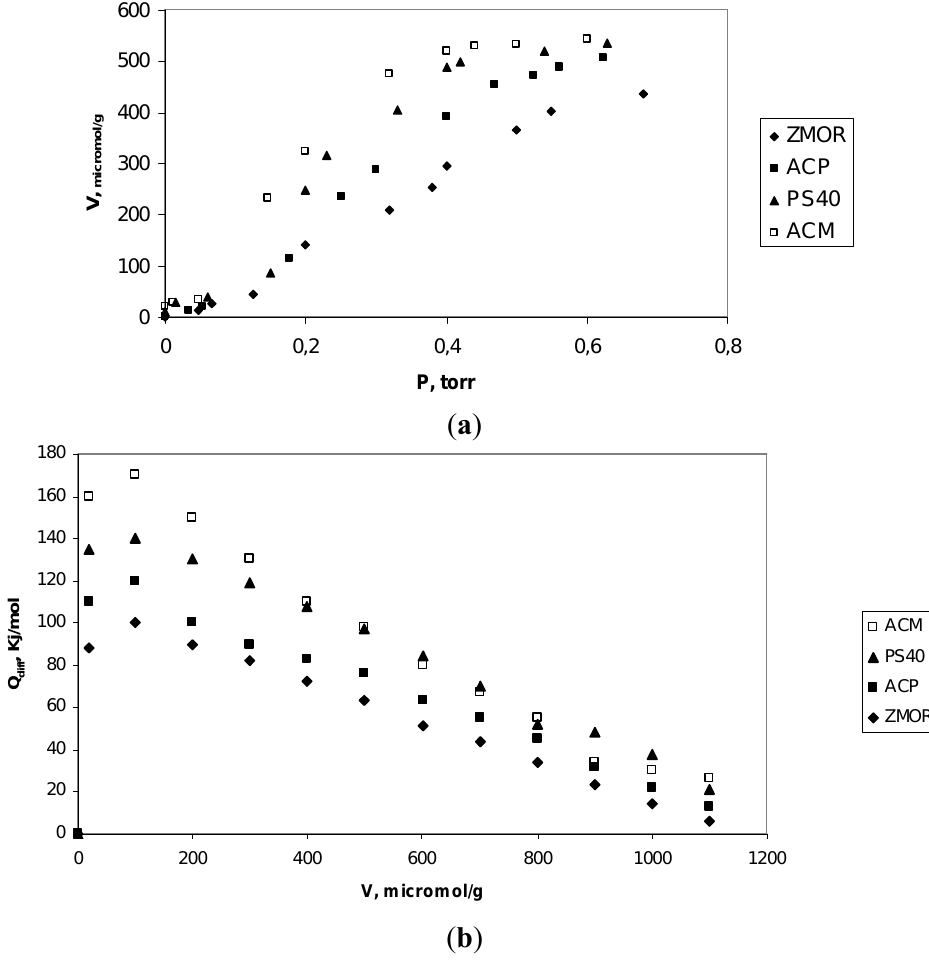
Figure 2. The adsorption of ammonia on the samples synthesized. ( a ) volumetric isotherm